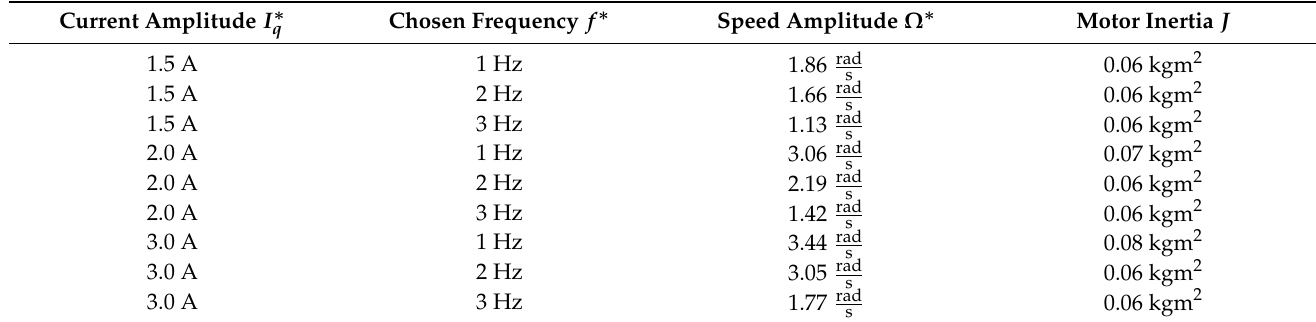
Table 3. Motor inertia